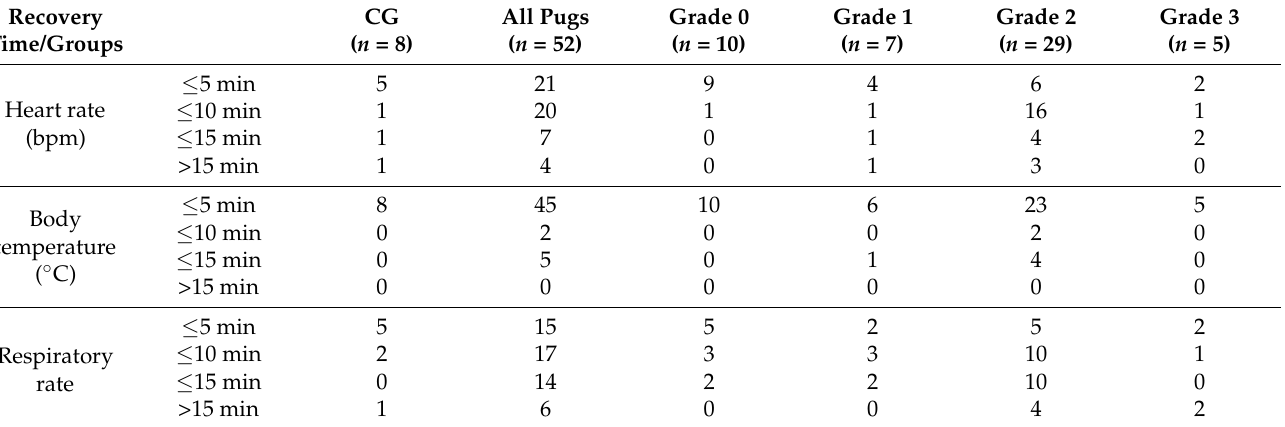
Table 7. Number of pugs (total and divided into BOAS grades 0–3) and dogs in the control group (CG) that recovered in ≤ 5, ≤ 10, ≤ 15 min or >15 min in terms of heart rate (beats per minute (bpm)), body temperature ( ◦ C), and respiratory